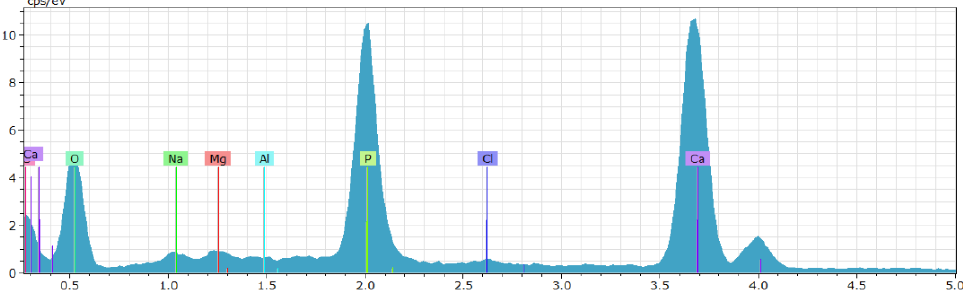
Figure 1. Compositional spectrum of the surface of O3.3 sample obtained using the EDX technique. Table 1. Compositional analysis results obtained using EDX. Values are displayed with respective standard deviations.